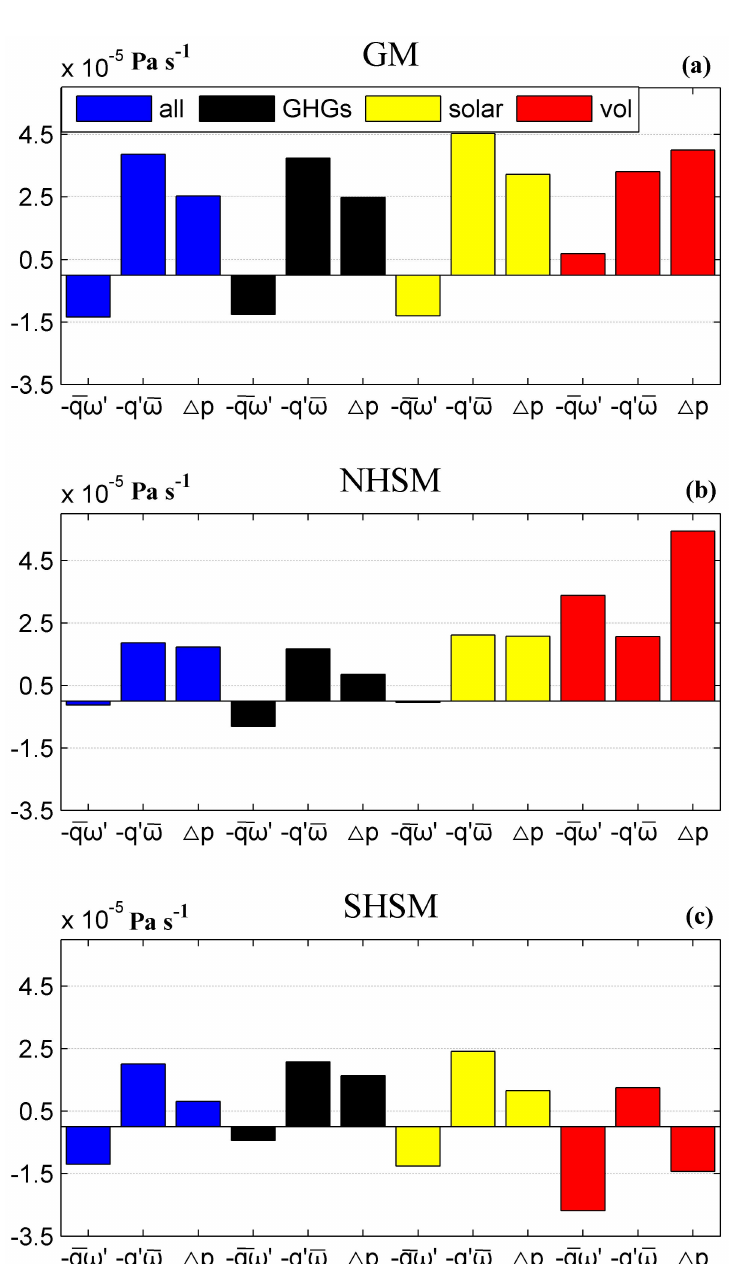
Figure 4. Decomposition of precipitation change in different external forcing run. The x -axis represents − q ω (cid:48) , − q (cid:48) ω , and their sum ( ∆ P) in all forcing (blue), GHG forcing (black), solar forcing (yellow), and volcanic forcing (red) for GM ( a ), NHSM ( b ) and SHSM ( c ) Each field is scaled to have the same global-mean temperature anomaly (PWP minus LIA) as the full